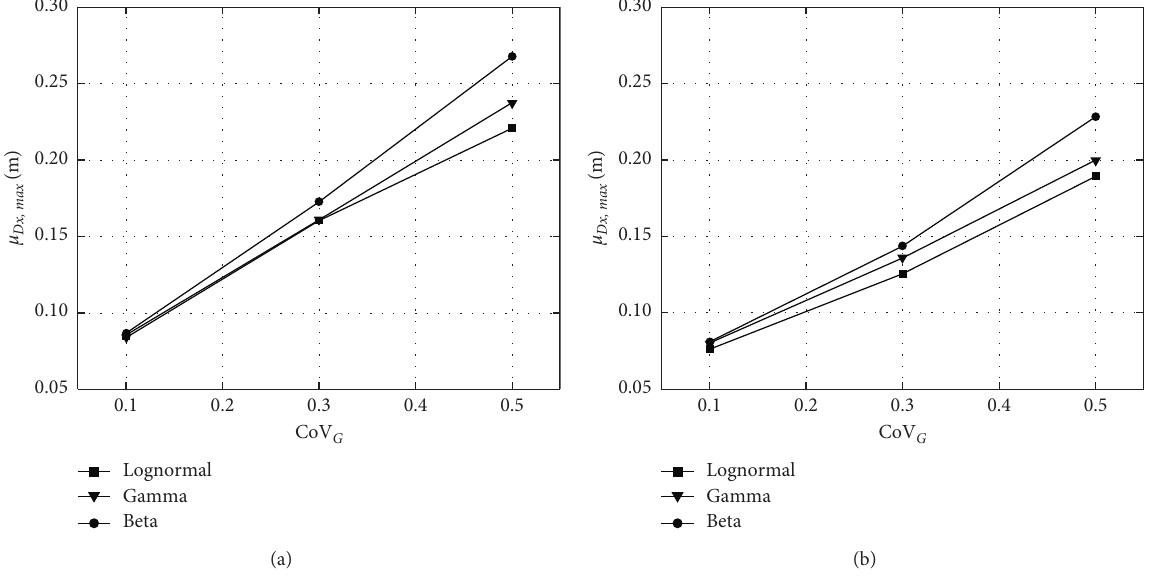
Figure 6: Variation of μ